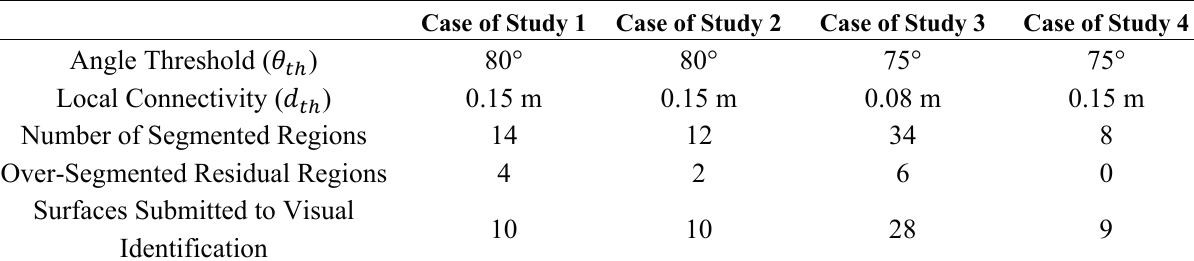
Table 4. Segmentation results.